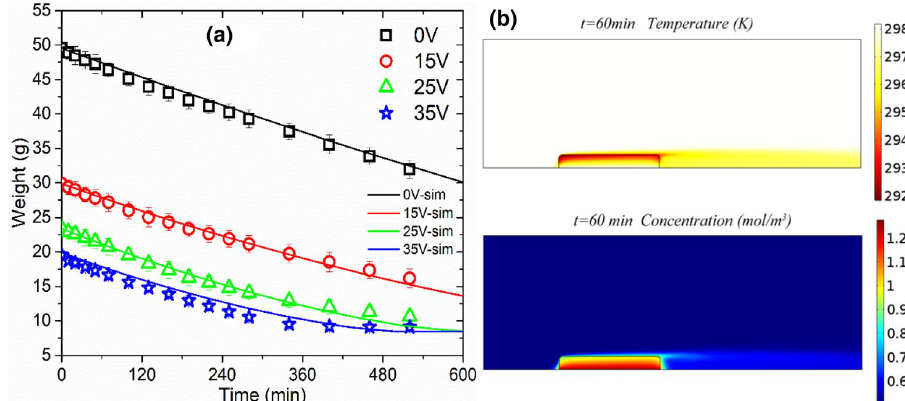
Figure 8. After electro-dewatering, ( a ) sludge air-drying mass curve, simulated and verified by experiment. ( b ) Simulated water vapor concentration and temperature distribution at 60 min (35